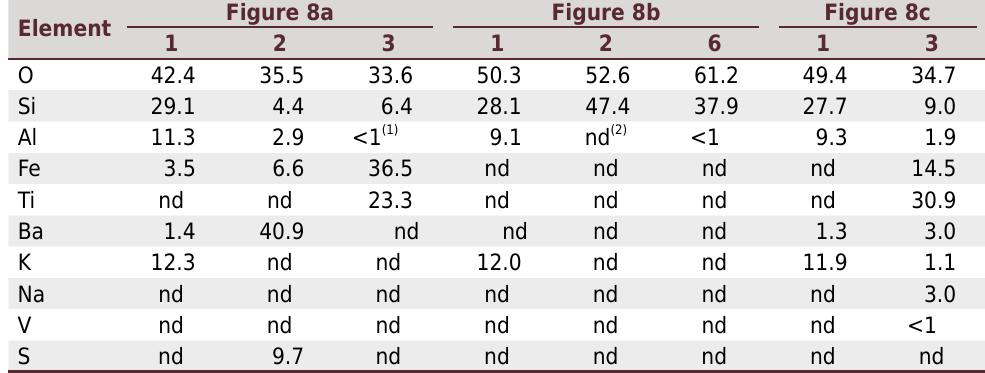
Table 6. Chemical analysis (% - m/m) of sample 25 for selected sand particles identified in figure 8